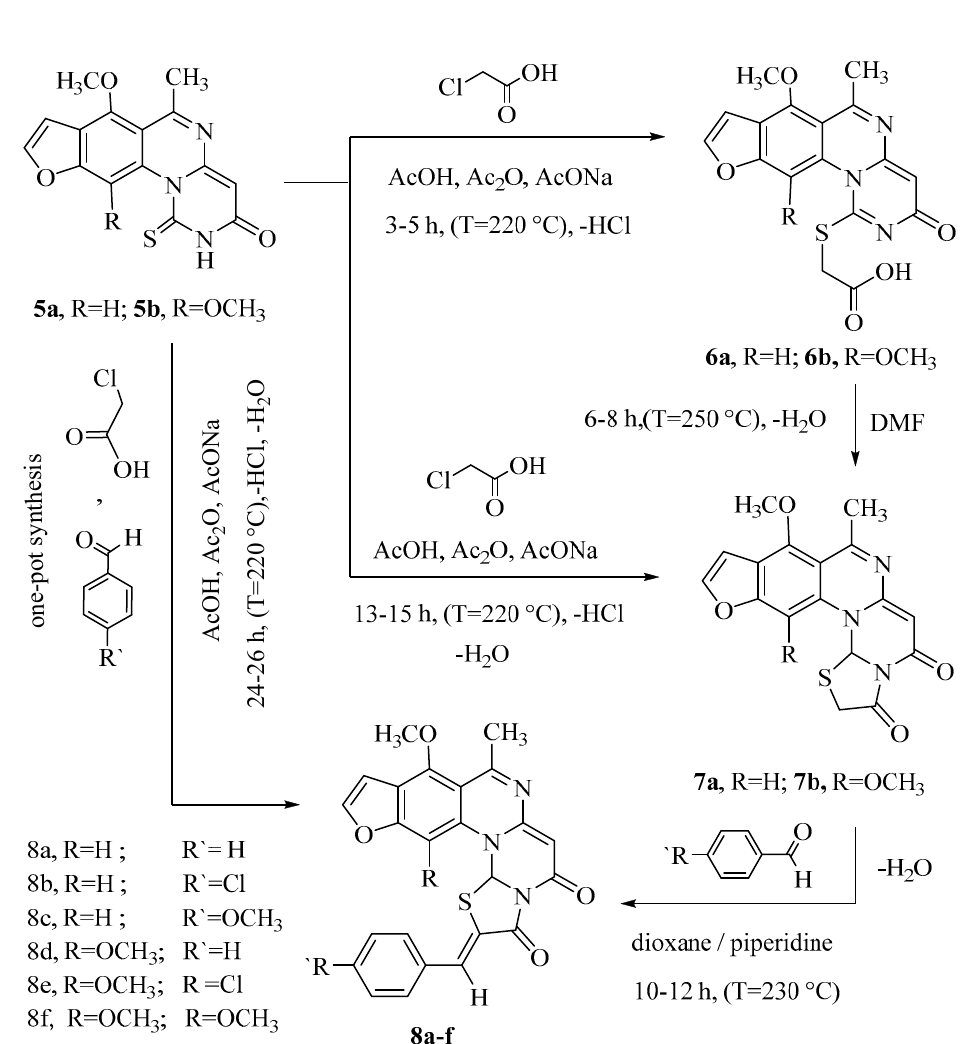
Scheme 2. Synthesis of furothiazolopyrimidoquinazolinone